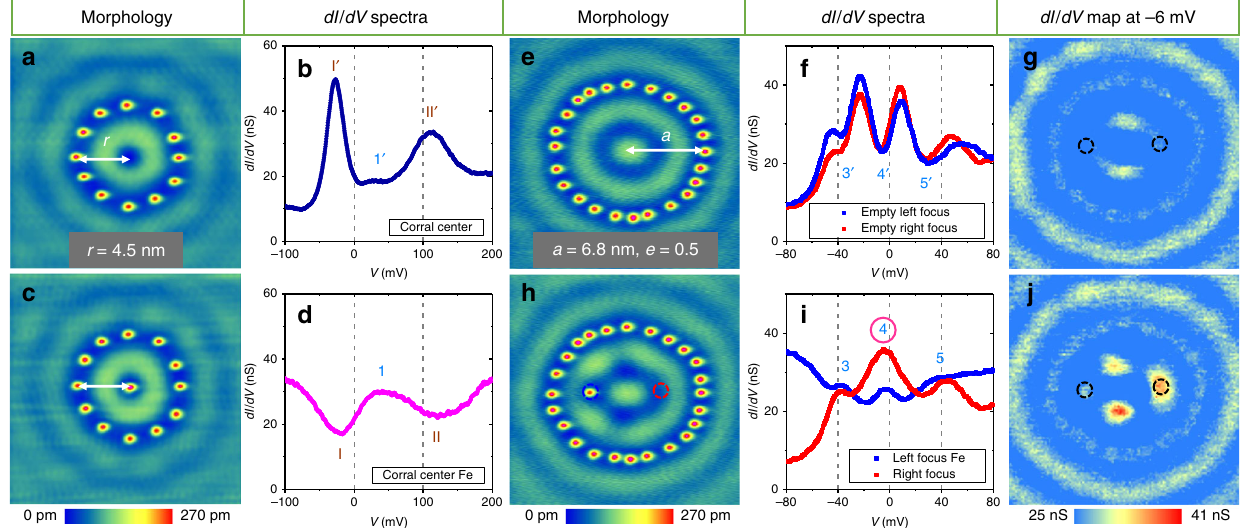
Fig. 1 Inversion effect and quantum mirage. a Topography of a CQC (radius r = 4.5 nm) built with 12 Fe adatoms. b dI/dV spectrum obtained at the corral center with its peaks labelled by wine Roman numerals with apostrophe and a valley labelled by cyan Arabic numeral with apostrophe. c Topography of the same corral with an additional Fe adatom placed at the center. d dI/dV spectrum atop the center Fe adatom with its valleys labelled by wine Roman numerals and a peak labelled by cyan Arabic numeral. e Topography of an EQC ( a = 6.8 nm and e = 0.5). f The corresponding dI/dV spectra obtained at the left focus (blue circle) and right focus (red circle) of the EQC. The valleys are labelled by cyan Arabic numerals with apostrophe. g dI/dV map of the EQC at − 6 mV. h Topography of the same EQC but with an additional Fe adatom placed at the left focus. i dI/dV spectra obtained atop the Fe adatom placed at left focus (blue) and at the right focal position (red). The peaks are labelled by cyan Arabic numerals. j dI/dV map of the EQC in h at − 6 mV. The dashed circles in g , h , j mark the focal positions of the